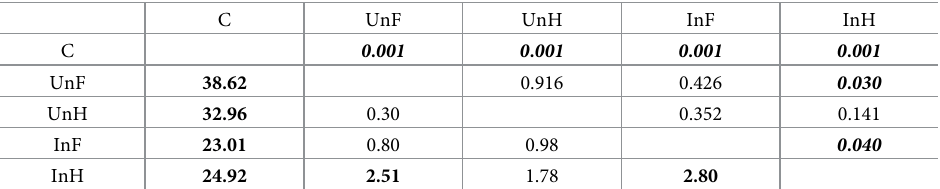
Table 2. PERMANOVA analysis of different groups with the weighted unifrac